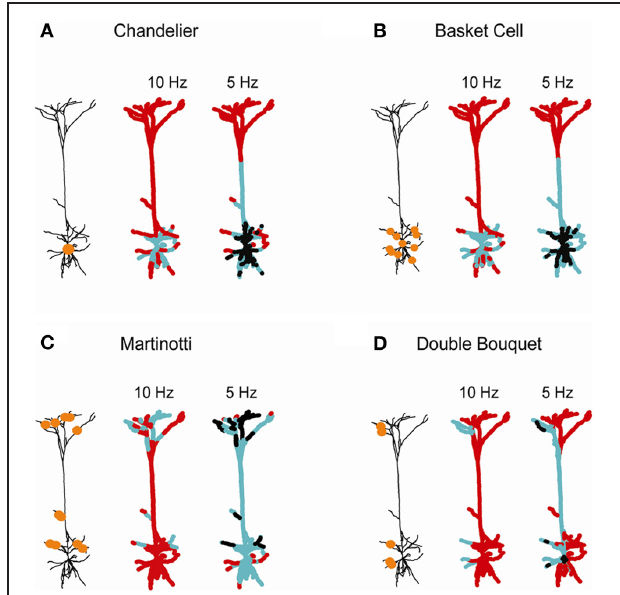
FIGURE 6 | Domain-specific dendritic inhibition shapes regional excitatory plasticity. Four inhibitory subclasses impinging on the postsynaptic layer 5 cortical pyramidal cell are modeled: (A) Chandelier; (B) basket; (C) Martinotti; and (D) double bouquet. In each case the schemes on the left depict the locations of the inhibitory synapses (orange circles). The conductance of the Chandelier inhibition in (A) was g inh = 25nS. In (B–D) each inhibitory contact exerted g inh = 1nS [with 25 contacts in (B,C) and 10 contacts in (D) ]. Two thousand three hundred and sixty-six excitatory synapses were uniformly distributed over the modeled tree and randomly activated either at 7Hz (middle) or at 10Hz (right). The strength of the excitatory synapses after 60s of simulation is color-coded, superimposed on the modeled L5 dendrite. Black—protected region ( w exc = 1), cyan—LTD ( w exc < 1), and red—LTP ( w exc >